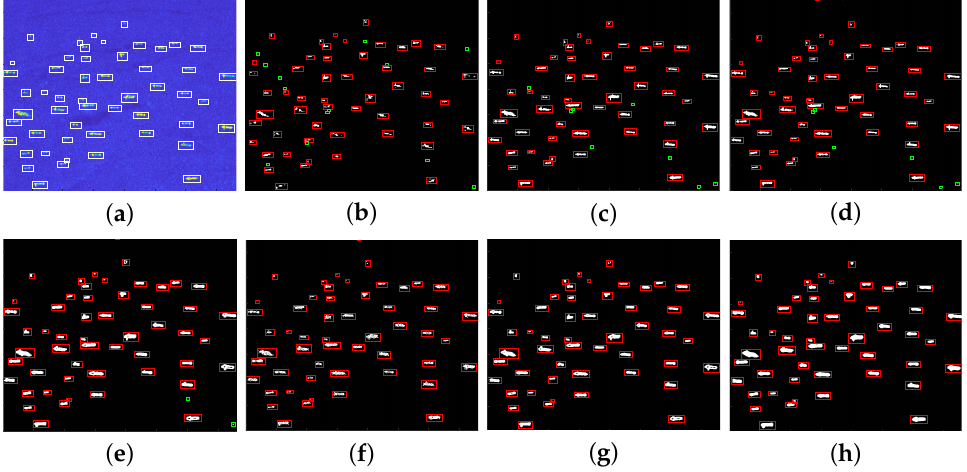
Figure 10. Detection results of different methods for scene 4. ( a ) original image; ( b ) CA-CFAR method; ( c ) G Γ D-CFAR method; ( d ) new LN-2PCFAR method; ( e ) MVWIE method; ( f ) FMPCM method; ( g ) IG method; ( h ) proposed method.